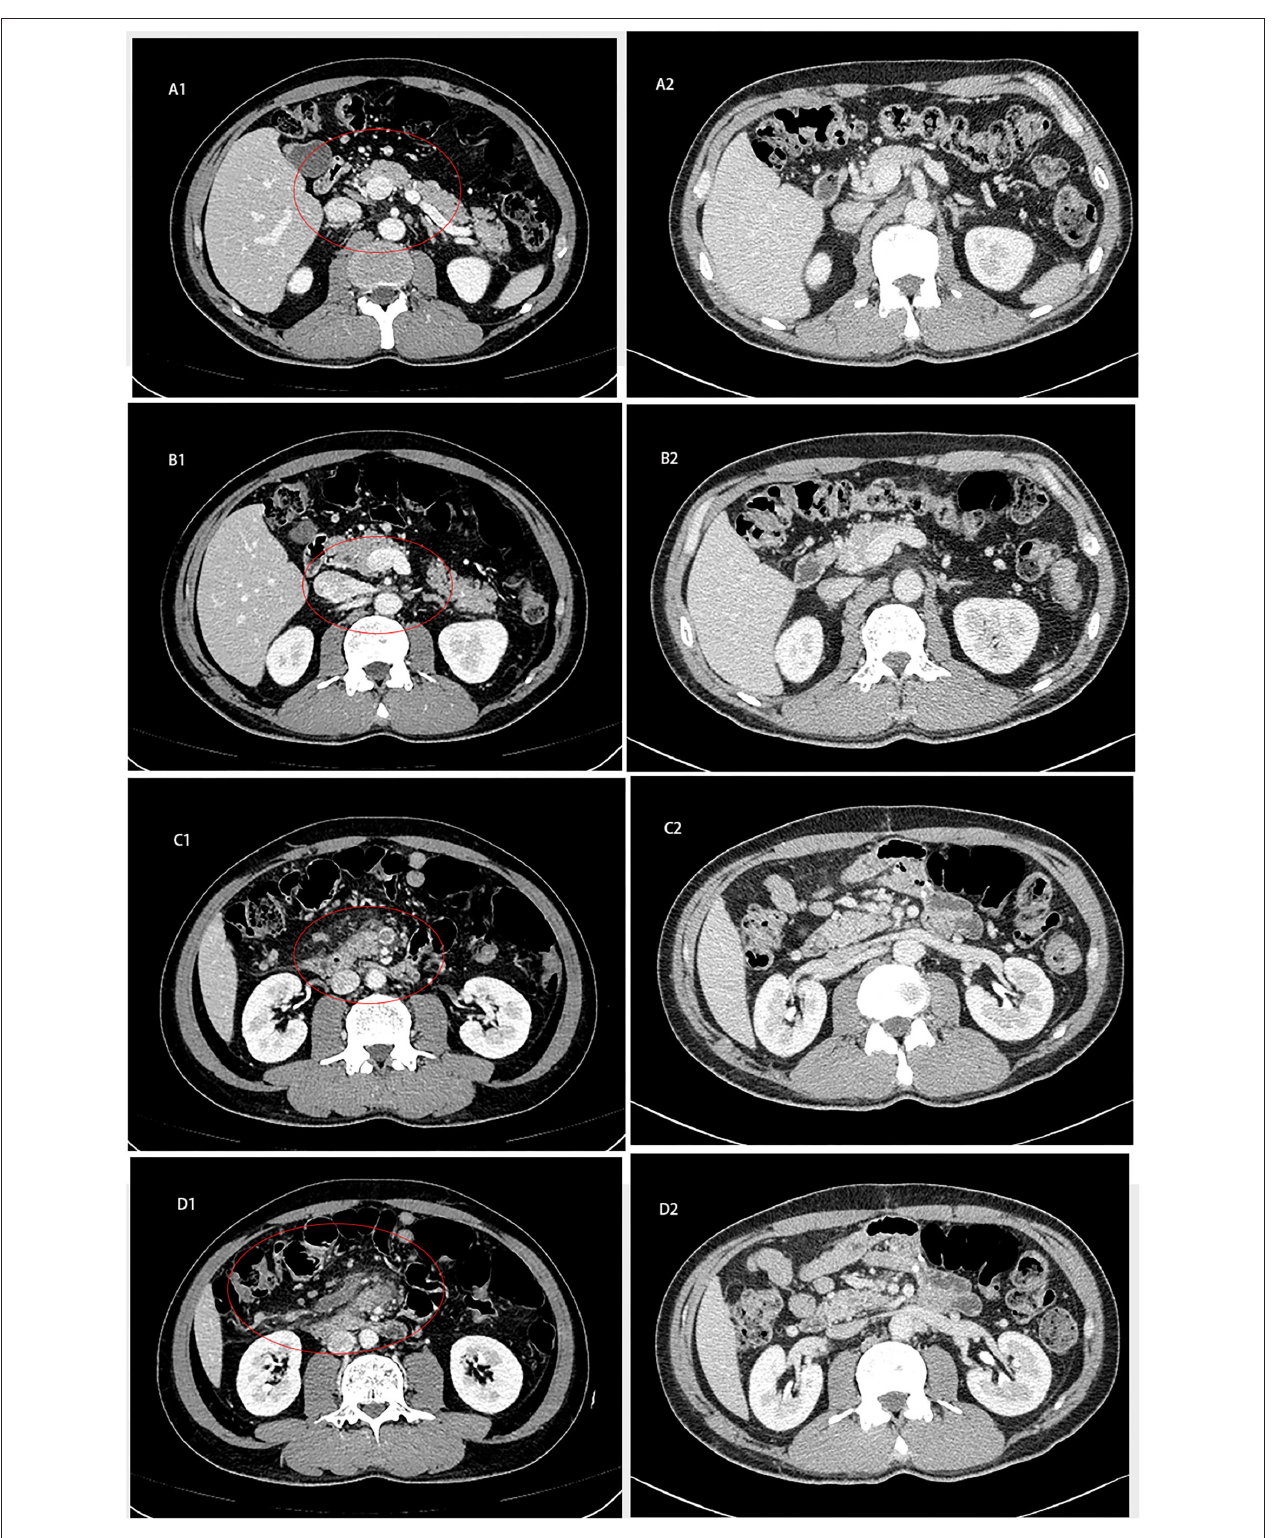
FIGURE 1 | Abdominal computed tomography of patient. (A1–D1) Contrast-enhanced CT on February 2, 2020 showed that the small intestine in the right middle abdomen was occupied by tumor with multiple enlarged lymph nodes. (A2–D2) Abdominal CT on October 6, 2020 showed that the obstruction of intestinal lumen was relieved after operation